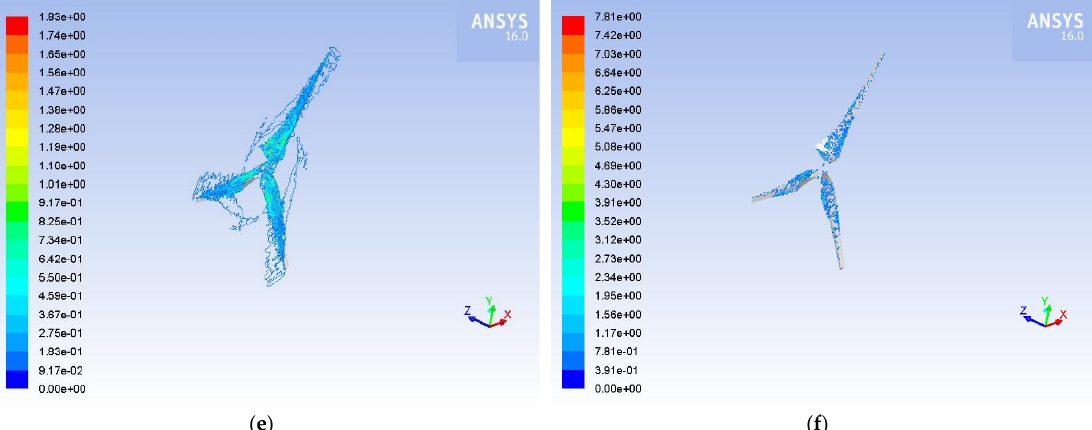
Figure 11. Concentration of sand particles close to the wind turbine rotor for: ( a ) u = 10 m·s − 1 , Q = 1%; ( b ) u = 15 m·s − 1 , Q = 1%; ( c ) u = 10 m·s − 1 , Q = 5%; ( d ) u = 15 m·s − 1 , Q = 5%; ( e ) u = 10 m·s − 1 , Q = 10%; ( f ) u = 15 m·s − 1 , Q = 10%.